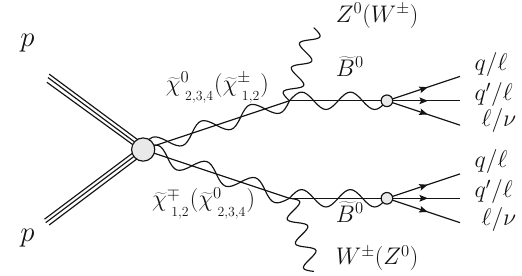
Fig. 6 Production of a chargino pair, chargino-neutralino or a neu- tralino pair, each decaying to a long-lived bino-like neutralino giving rise to a displaced signal